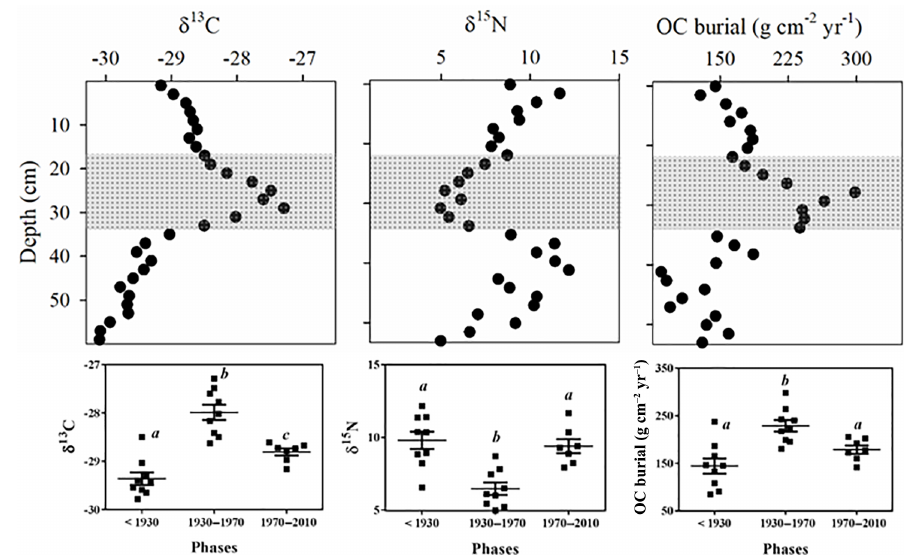
Figure 7. δ 13 C, δ 15 N and carbon burial rate values in relation to depth (cm). Panels below each vertical profile represent respective data grouped by the three general phases < 1930, 1930–1970 and 1970–2010. Filled square symbols represent means of a given variable in each sediment layer, and the vertical bars show the mean with the SD of the respective phase. Equal letters in each panel represent non-significant differences ( p > 0 . 05, one-way ANOVA followed by Tukey’s post test).